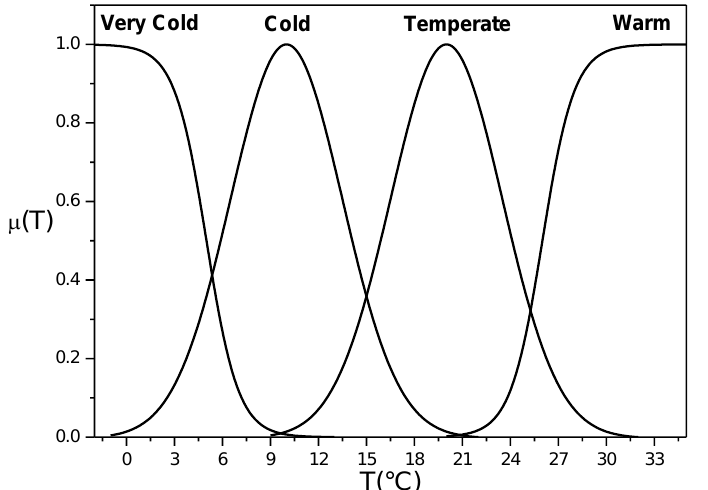
Figure 3. Granulation of the variable T (whose values are expressed in Celsius degrees) in four fuzzy sets that are labelled by the adjectives written on top of them.